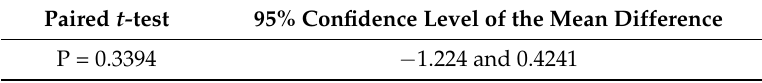
Table 7. Comparison of the two volume measurement methods by paired t -test. Paired t-